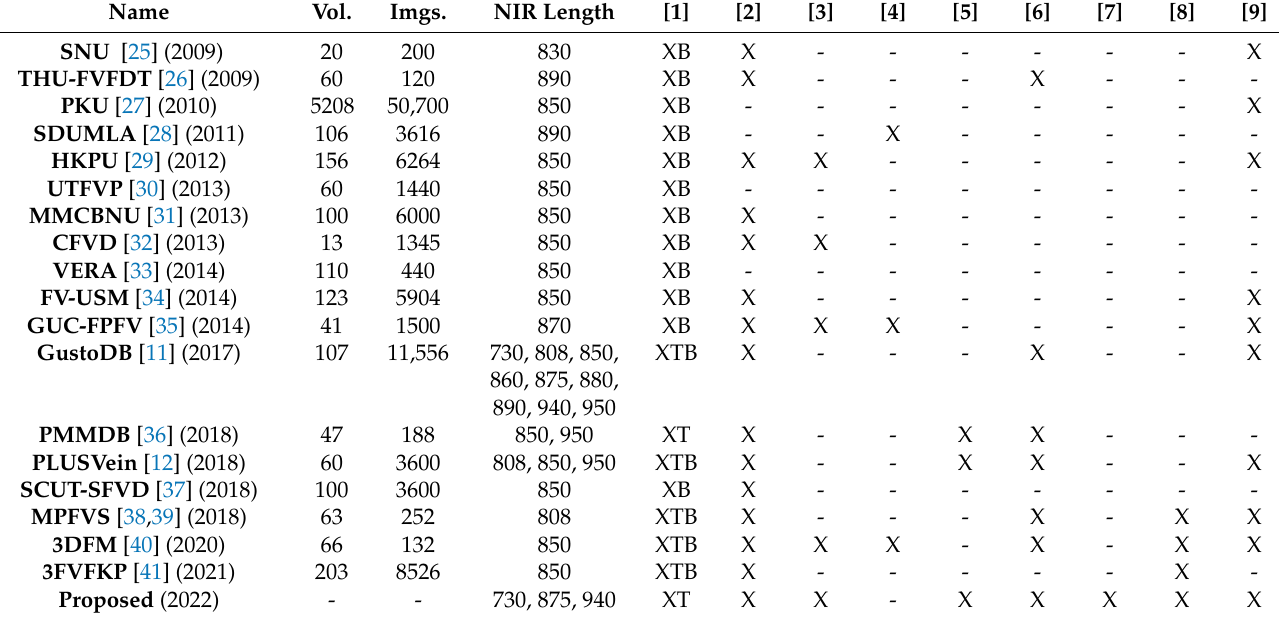
Table 1. Databases of known FVS biometric databases/devices